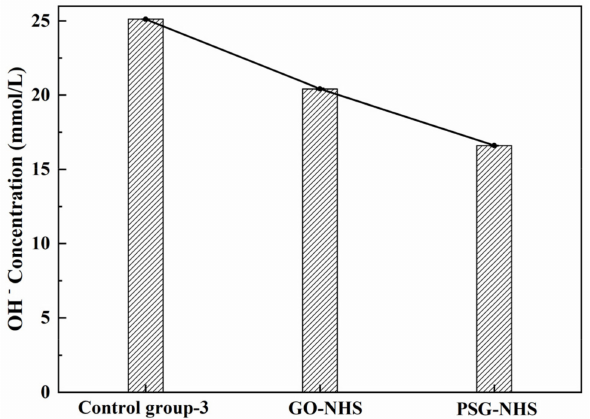
Figure 15. Ion concentrations in suspensions with Ca(NO 3 ) 2 solution with Ca 2+ concentration equal to that in Ca(OH) 2 solution(CHS).